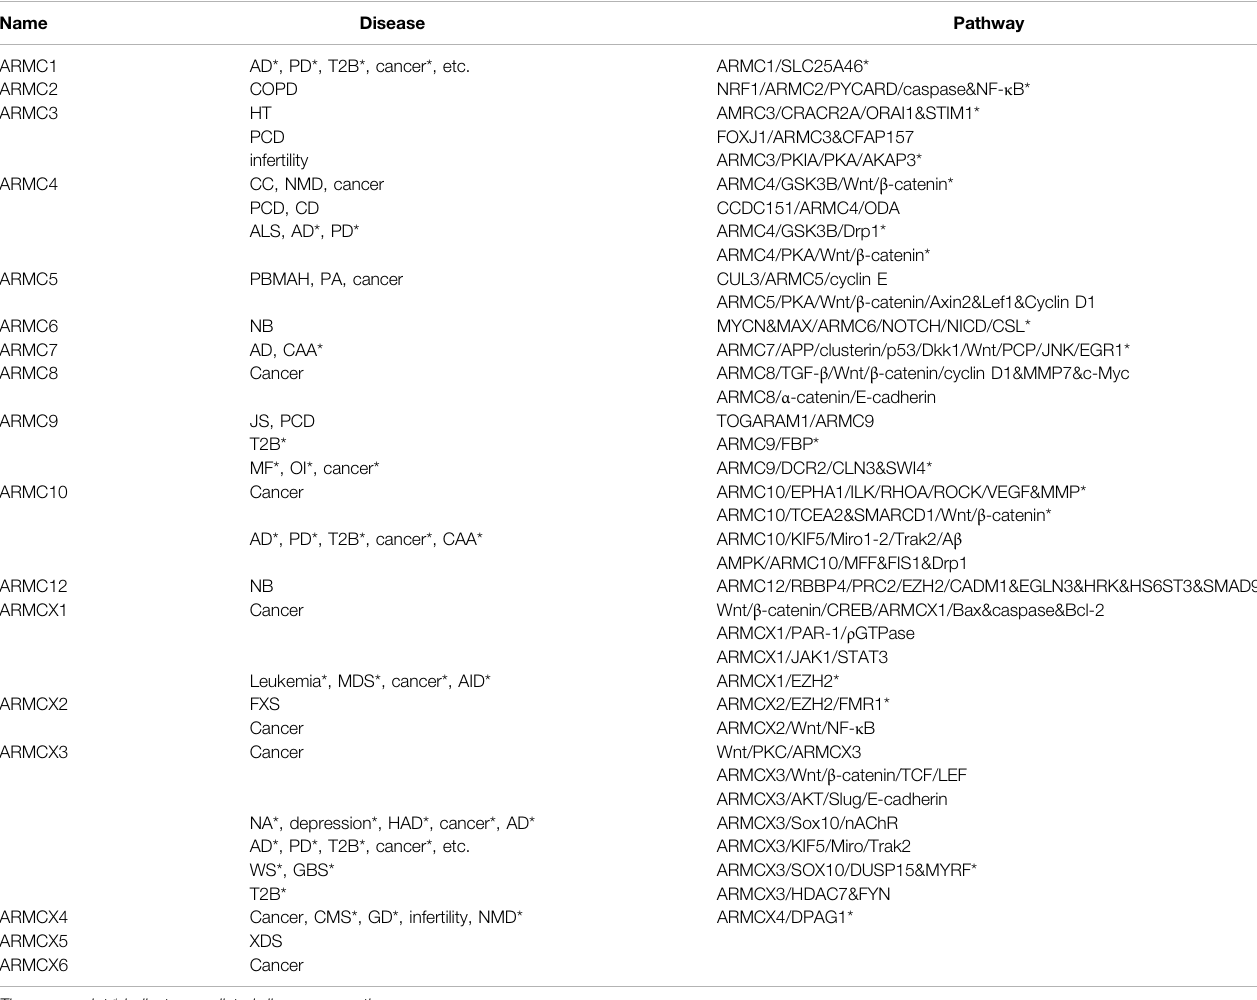
TABLE 1 | ARMC subfamily, diseases, and pathways. Name Disease